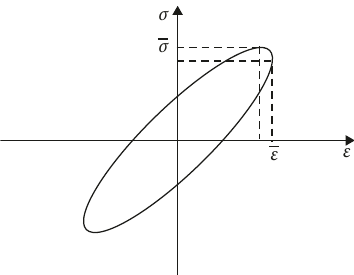
Figure 7: Stress-strain curve of Kelvin